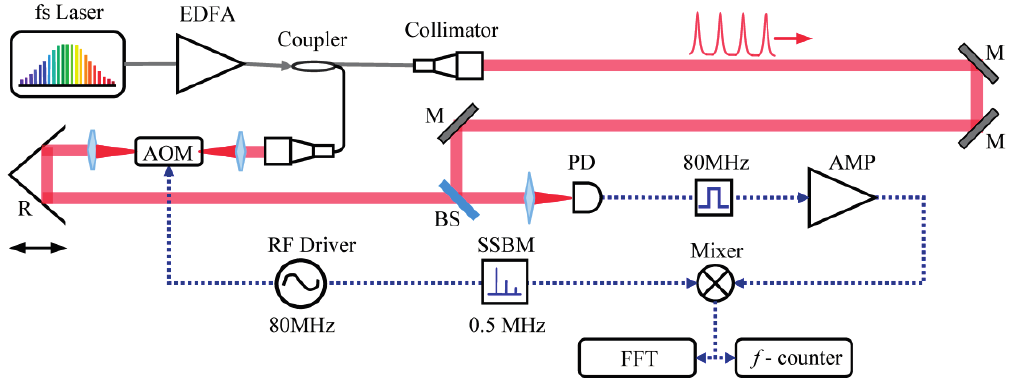
Figure 4. Schematic of the outdoor optical frequency transmission test